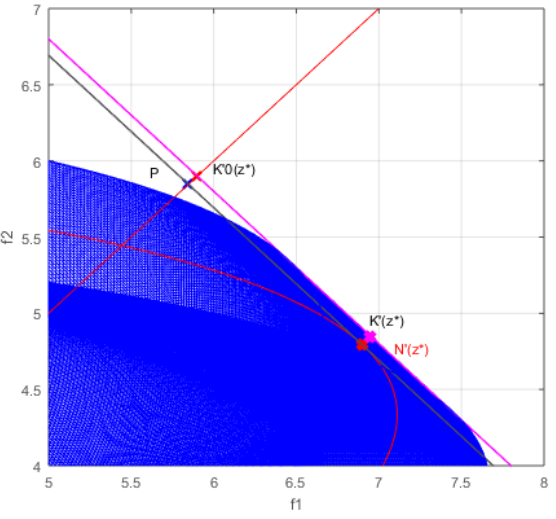
Figure 9. Proposed solutions of game G